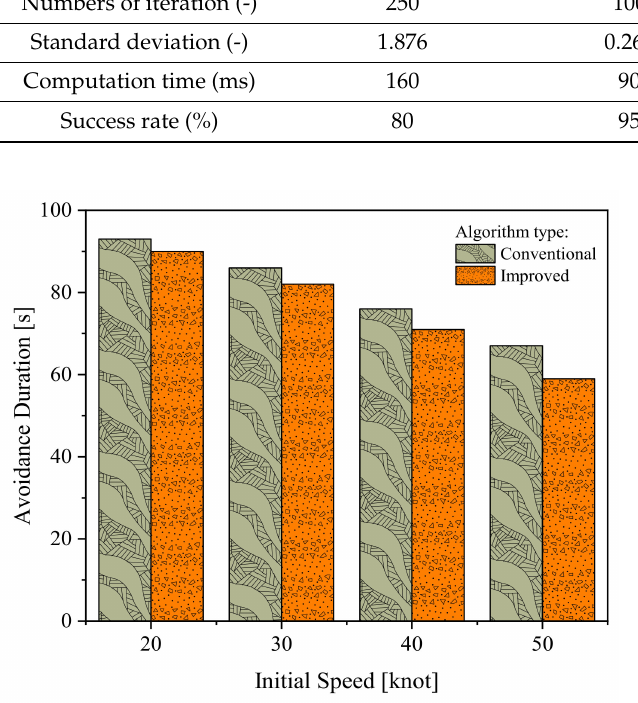
Figure 34. Comparison of the avoidance durations between two GA types [148].